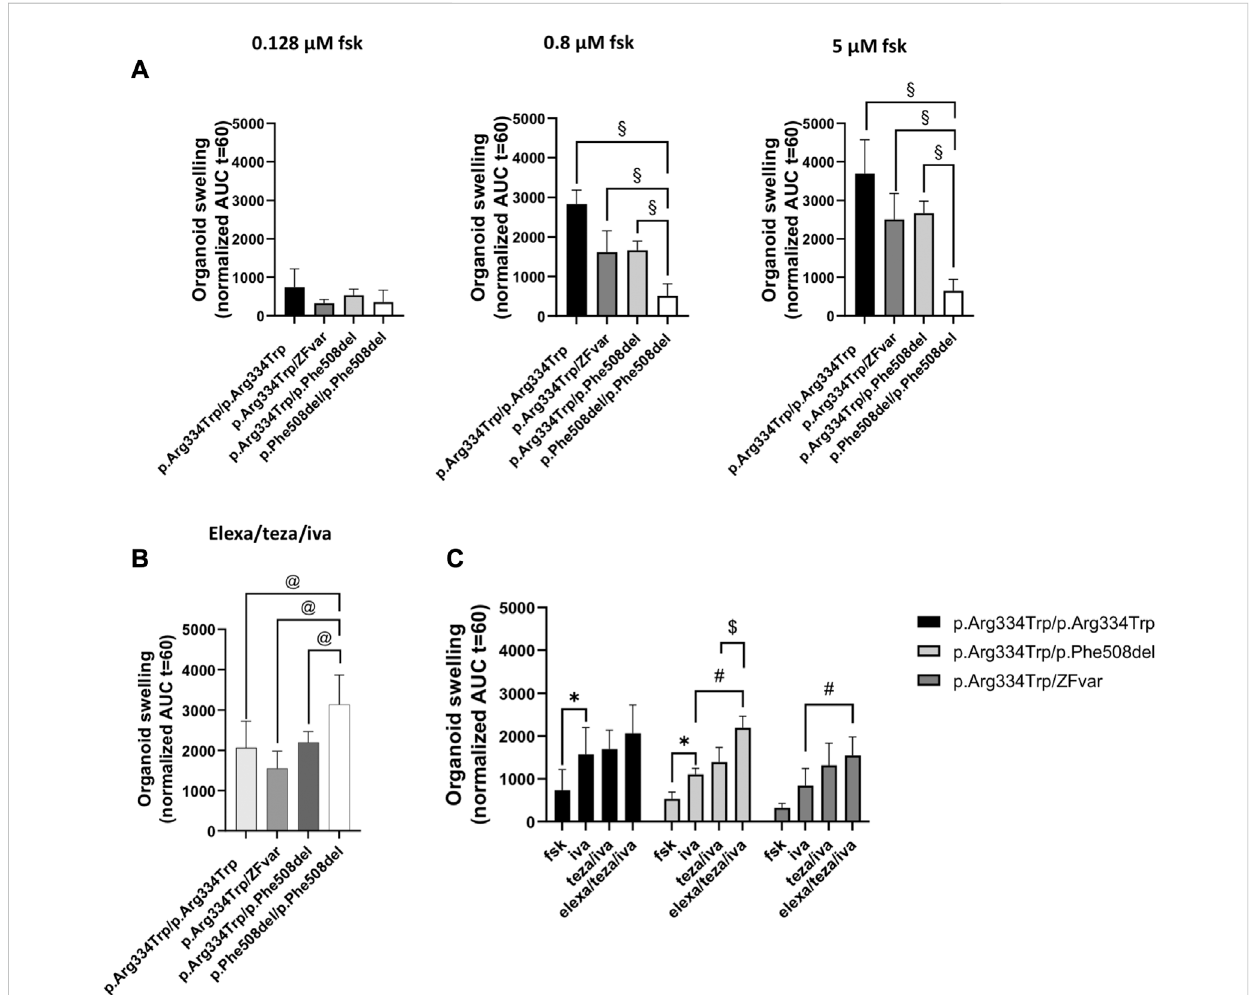
FIGURE 2 Comparison of the rescue of CFTR function by the three different modulators tested in intestinal organoids with p.Arg334Trp/p.Arg334Trp, p.Arg334Trp/ZFvar, and p.Arg334Trp/p.Phe508del genotypes. Organoid swelling is represented as area under the curve (AUC) of organoid surface area increase (baseline = 100%, t = 60 min) for stimulation with fsk alone or in combination with CFTR modulators. (A) Mean AUC of organoids carrying p.Arg334Trp/p.Arg334Trp, p.Arg334Trp/ZFvar, p.Arg334Trp/p.Phe508del at 0.128, 0.8 and 5 μ M fsk alone (B) Mean AUC of organoids at 0.128 μ M fsk treated with elexa/teza/iva. (C) Mean AUC of organoids carrying p.Arg334Trp/p.Arg334Trp, p.Arg334Trp/ZFvar and p.Arg334Trp/p.Phe508del at 0.128 μ M Fsk treated with fsk alone or in combination with CFTR modulators. Data represent the mean ± SEM of 6 – 10 replicates per condition. Signi fi cance was considered for p -value ≤ 0.05 and symbols represents signi fi cance vs.: § — stimulation with fsk alone in p.Phe508del/p.Phe508del organoids (ANOVA); @- stimulation with elexa/teza/iva in p.Phe508del/p.Phe508del organoids (ANOVA); * — stimulation with fsk alone (ANOVA); # — stimulation with iva + fsk (ANOVA); $ — stimulation with teza/iva + fsk